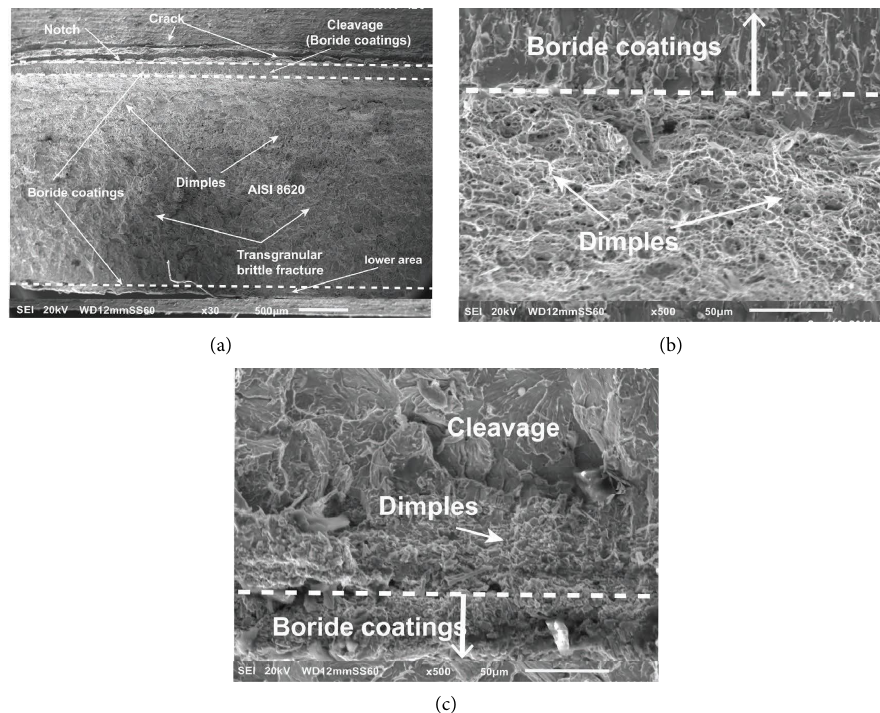
Figure 10: SEM fracture surface images on AISI 8620 borided at 1223K for 6h: (a) general view of the surface, (b) area close to the notch, and (c) lower specimen area.